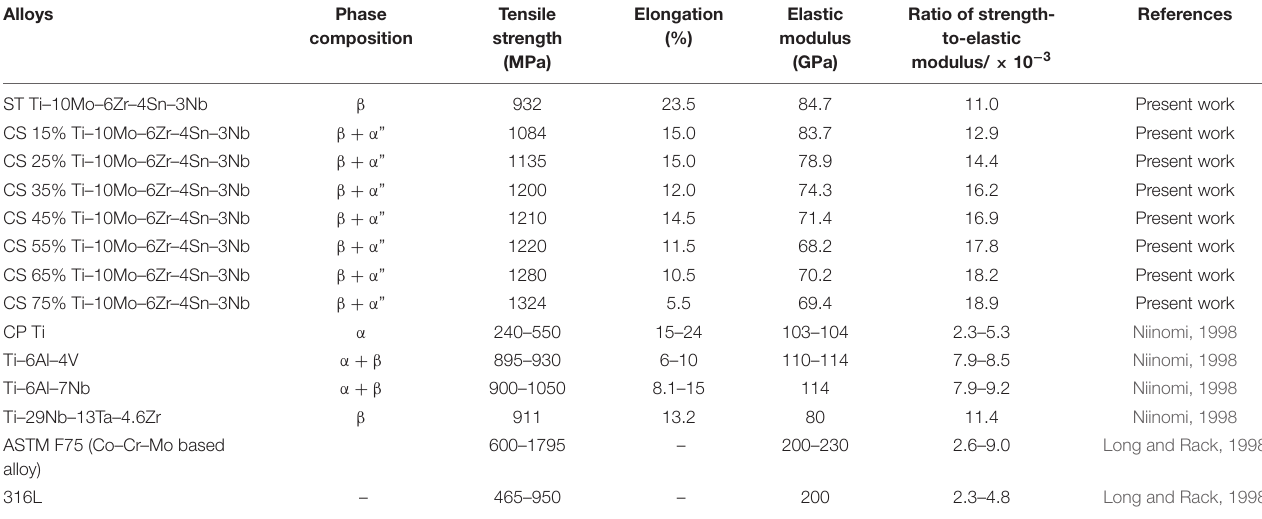
FIGURE 5 | Relationship between cold swaging reduction and mechanical properties of solution-treated and swaging deformed specimens, taken from the longitudinal direction: (A) tensile strength and (B) elastic modulus, and reduction of area. TABLE 2 | Mechanical properties of the Ti–10Mo–6Zr–4Sn–3Nb alloy and some typical metallic materials used for biomedical